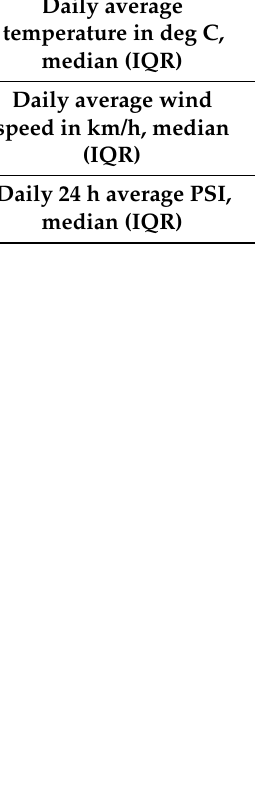
Table 2. Characteristics of the AMI patients by cluster (N = 39,287 AMI